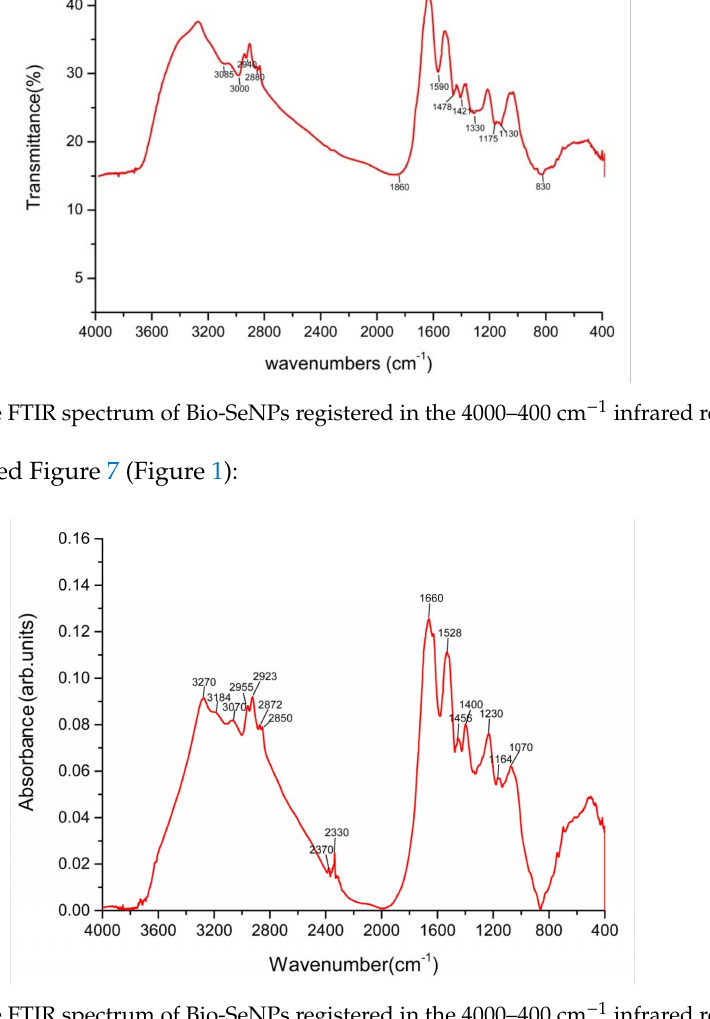
Figure 1. The FTIR spectrum of Bio-SeNPs registered in the 4000–400 cm − 1 infrared